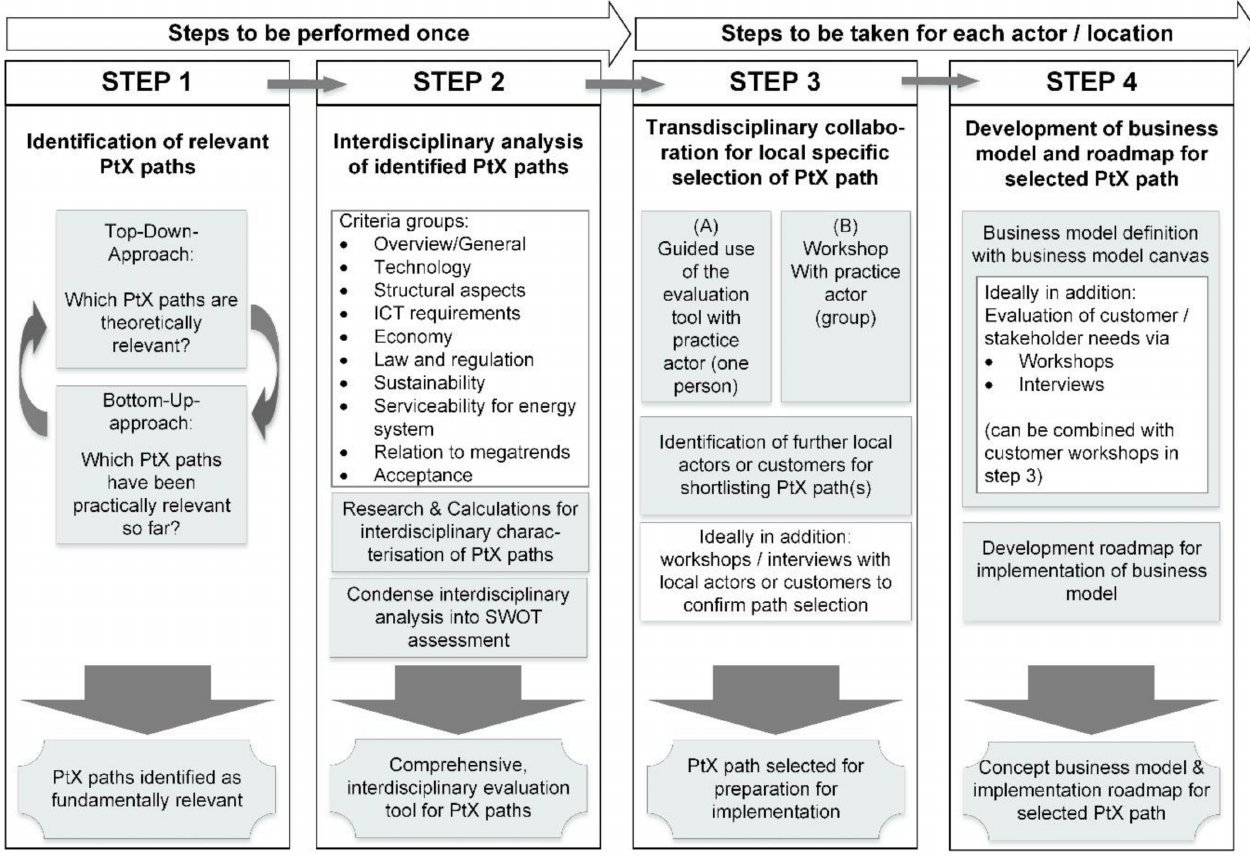
Figure 1. Overview of the developed integrated